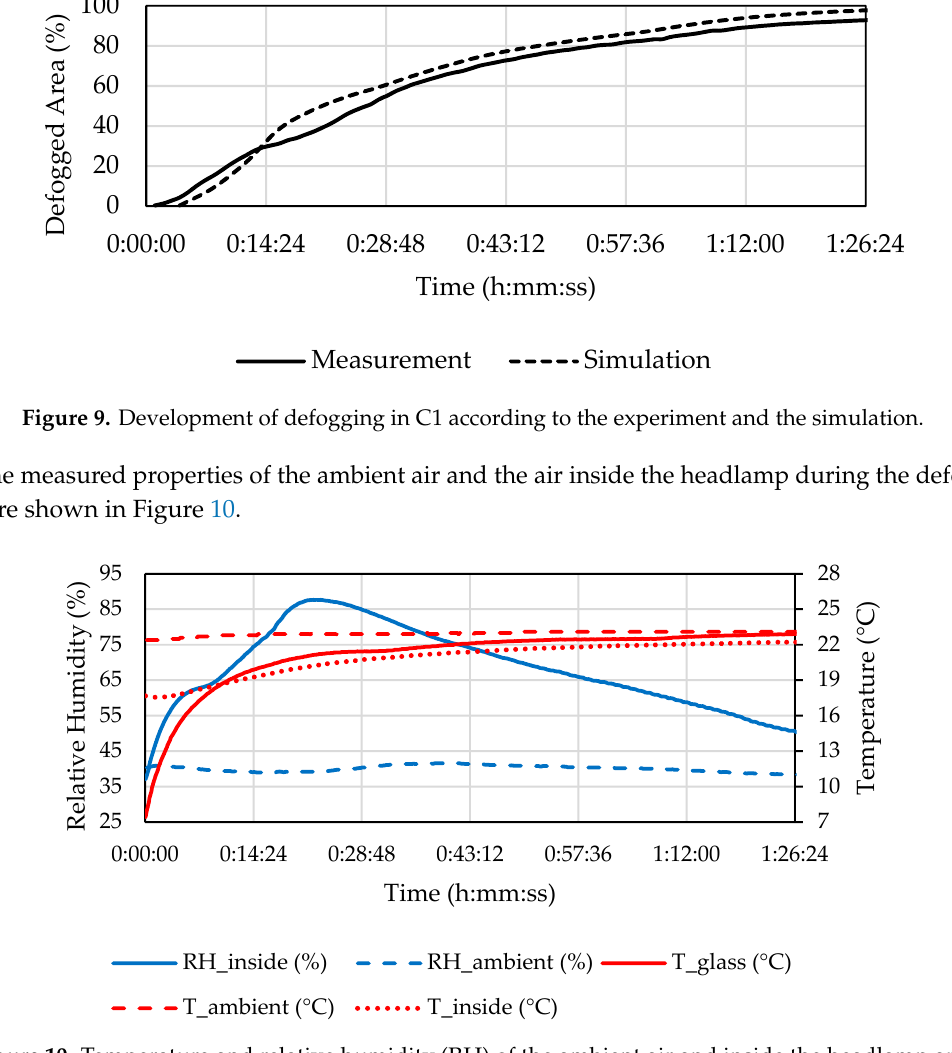
Figure 10. Temperature and relative humidity (RH) of the ambient air and inside the headlamp and the temperature of the front glass during the C1 defogging phase.